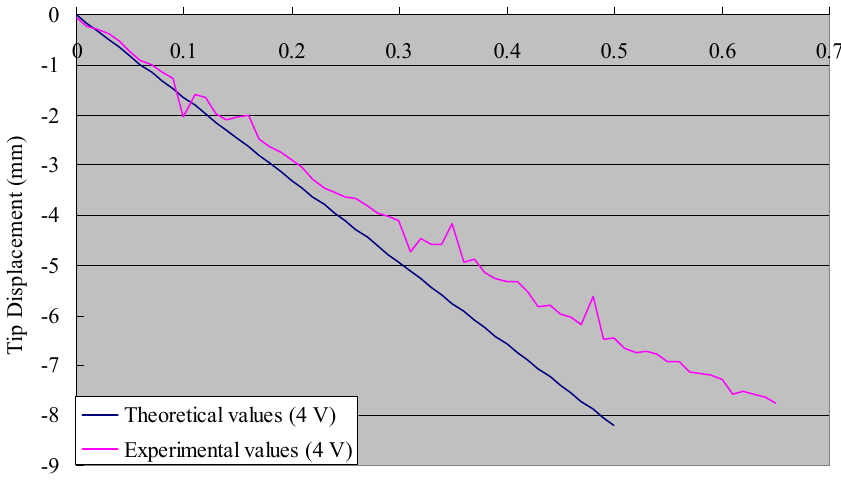
Figure 6. Relationship between the theoretical and experimental values (step